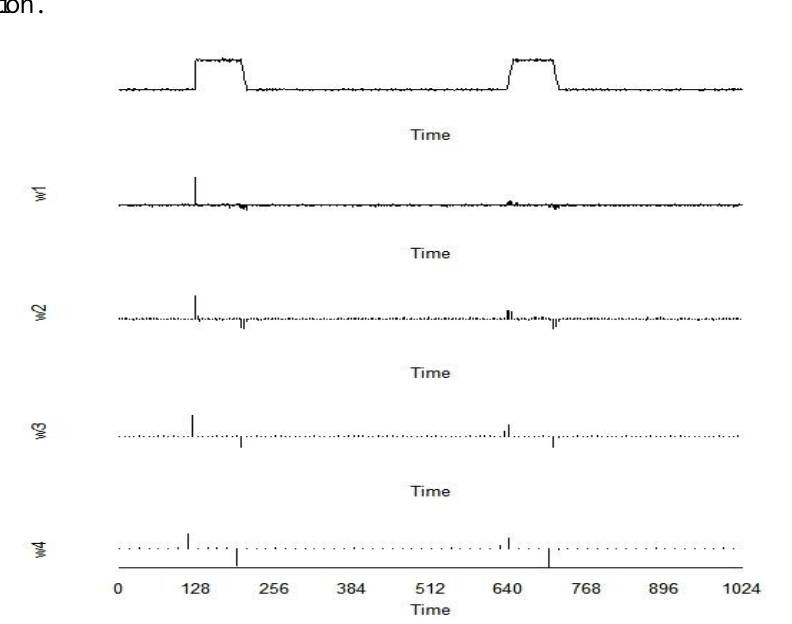
Figure 4. Haar-wavelet based change detection for two tank cycles. In the first cycle, there is an abrupt receipt and gradual shipment. In the second cycle, there is a gradual receipt and gradual shipment. Wavelet coefficients w 1– w 4 can be used alone or together for change